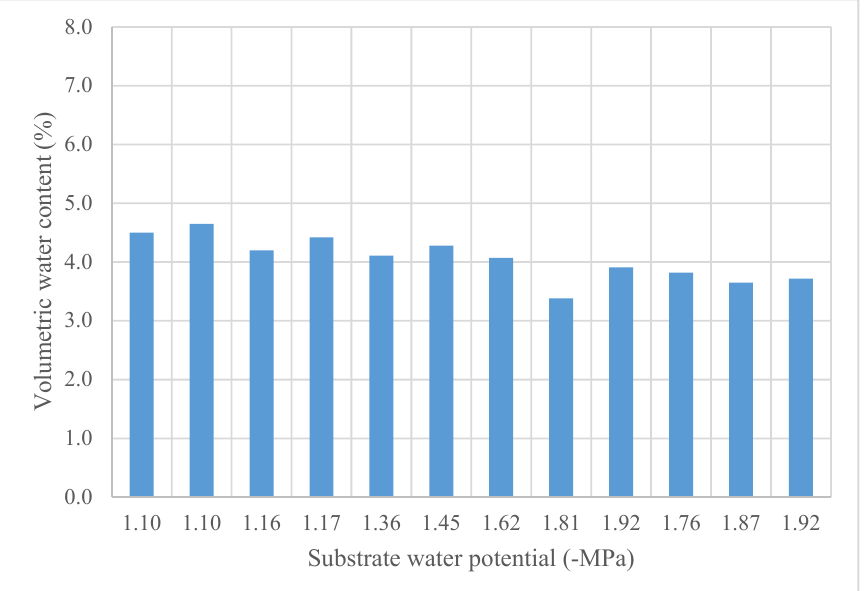
Figure 3. Example of individual sampling measurements of coconut coir. Variation of volumetric water content (VWC) was <1%. Data used to calculate values presented in Table 1.